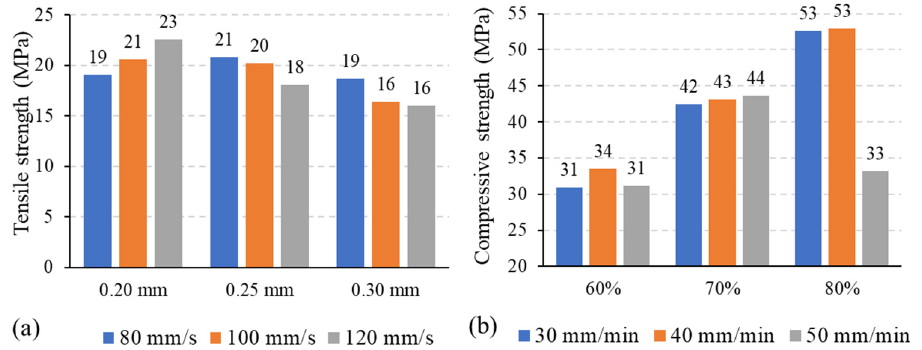
Figure 4. ( a ) PLA tensile strength sensitivity to printing speed with different layer thicknesses (in mm) and ( b ) compressive strength sensitivity to printing speed with different infill percentages (in %).